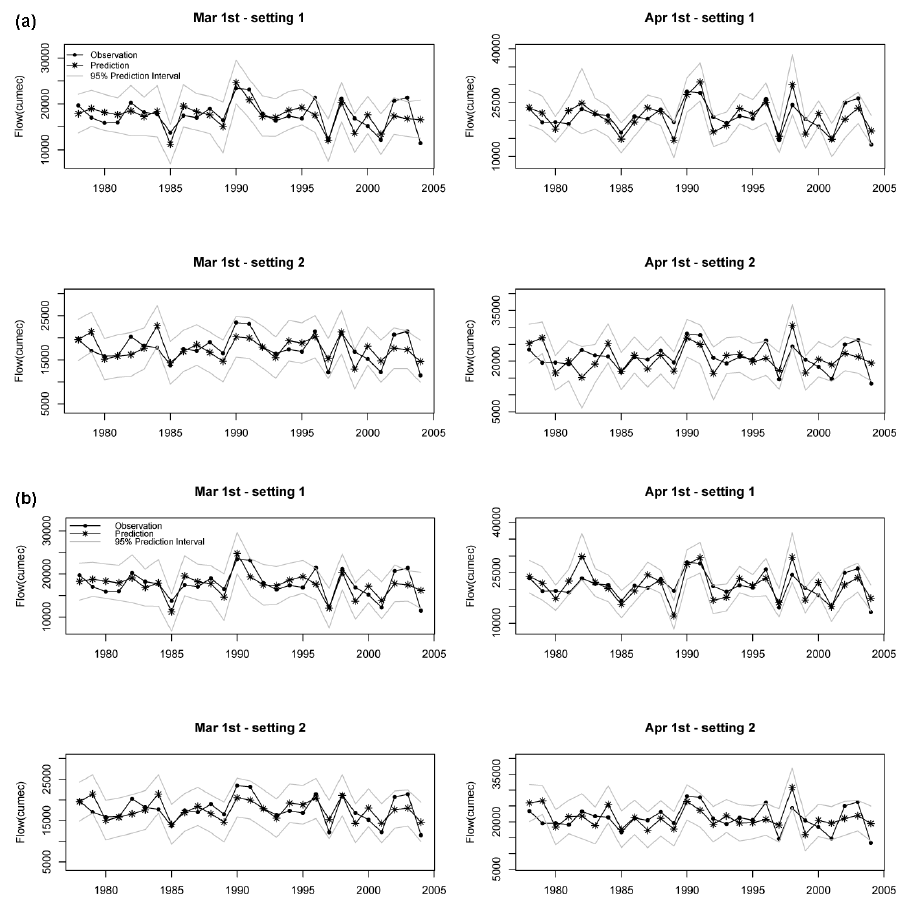
Fig. 7. (a) Cross-validated prediction for 1 March and 1 April (MAMJ and AMJ inflow) corresponding to different datasets used, i.e., settings 1 and 2 (AIC); (b) cross-validated prediction for 1 March and 1 April (MAMJ and AMJ inflow) corresponding to different datasets used, i.e., settings 1 and 2